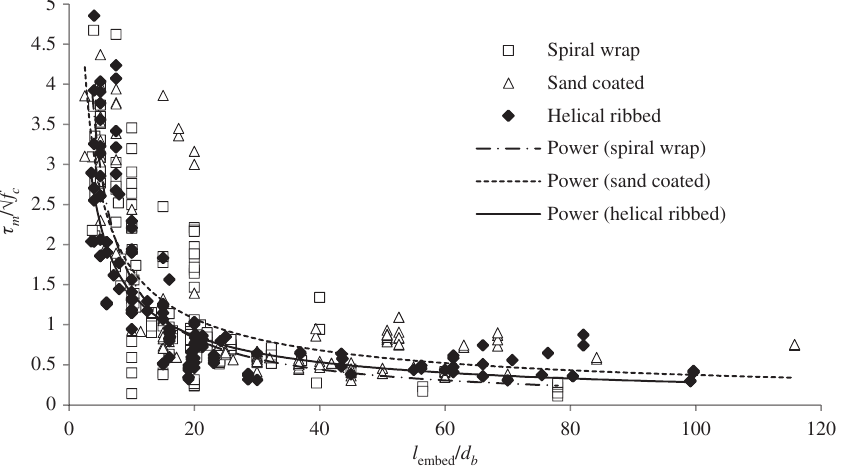
Figure 5: Normalised average bond stress of specimens against to the normalised embedment length for different bar